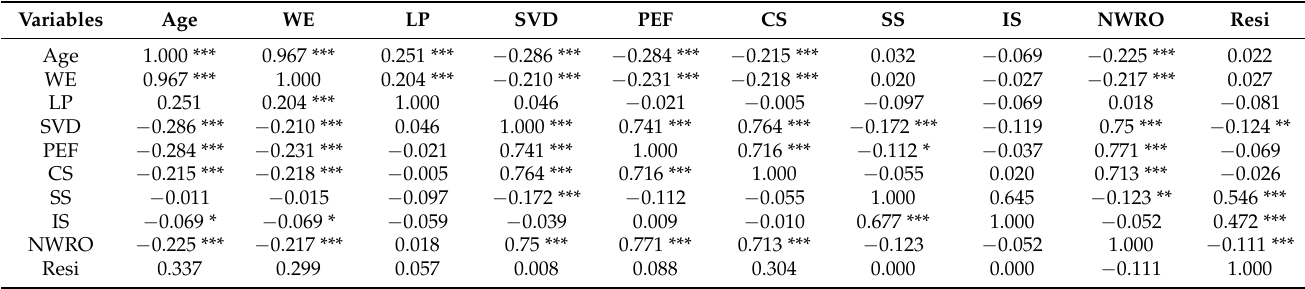
Table A1. Correlation of all continuous variables ( n =